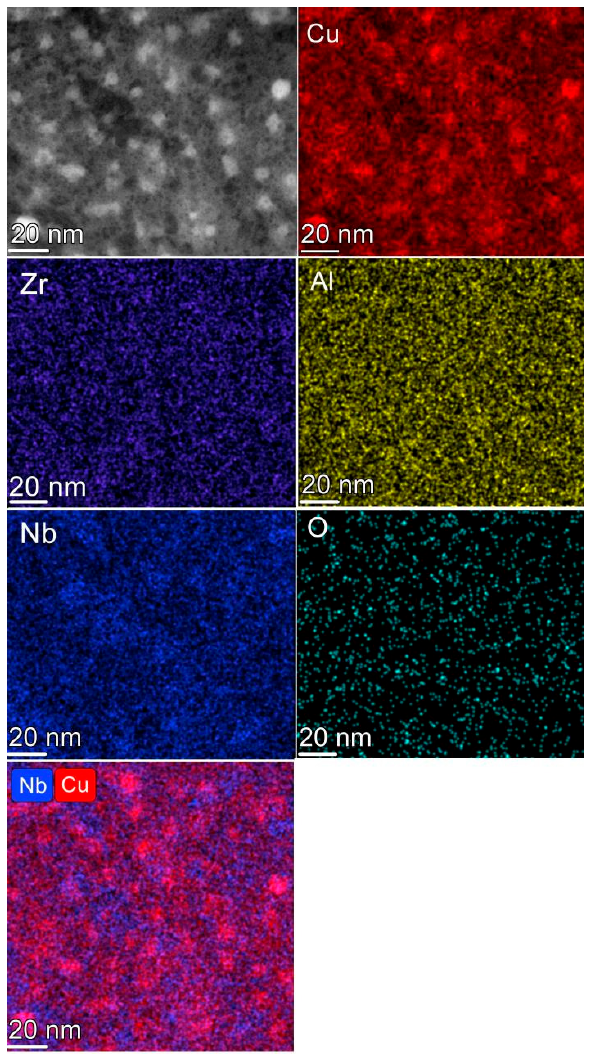
Figure 5. S ‐ TEM micrograph and the elementary distribution of the as ‐ cast Zr 52 Cu 42 Al 5.5 Nb 0.5 alloy. Figure 5. S-TEM micrograph and the elementary distribution of the as-cast Zr 52 Cu 42 Al 5.5 Nb 0.5